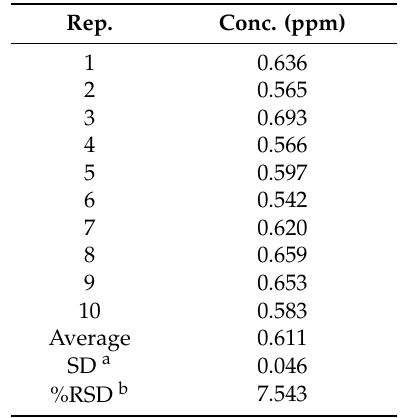
Table 7. Data used to calculate the limit of detection and limit of quantification of a GC–FID method used to measure ethanedinitrile in